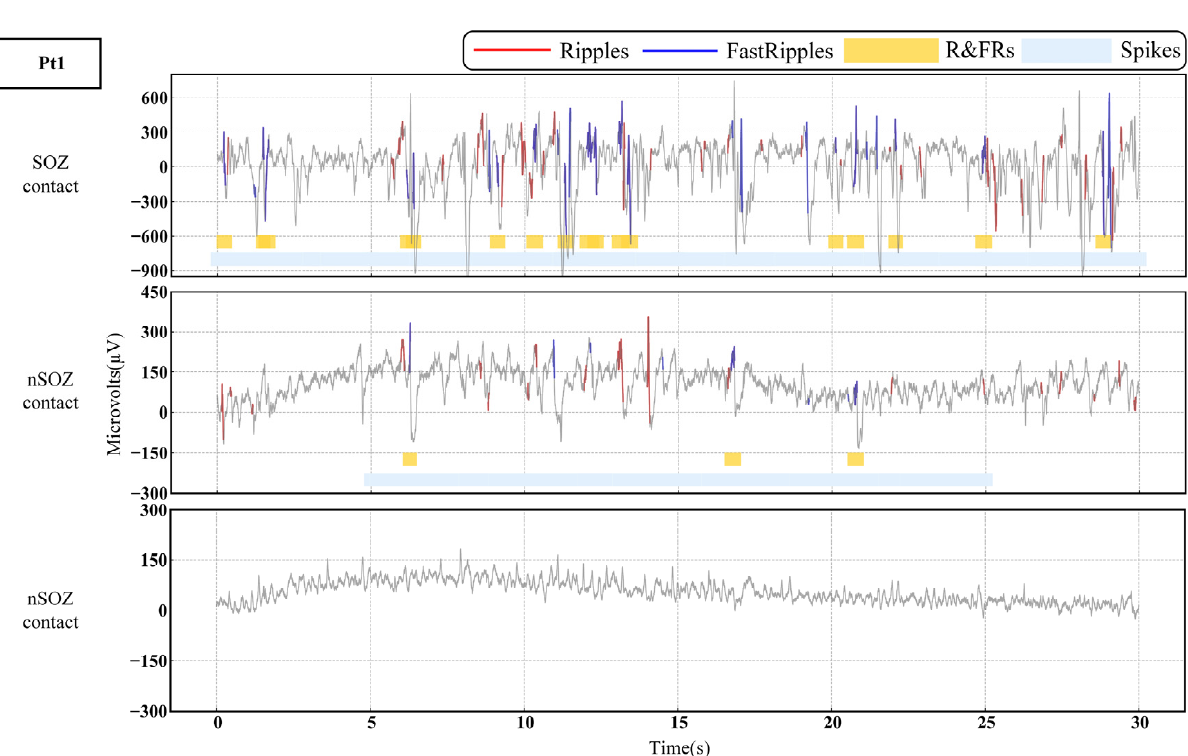
Figure 4. Raw interictal SEEG and multi epileptogenic biomarkers detection results plot in SOZ and nSOZ contacts for patient (Pt1).